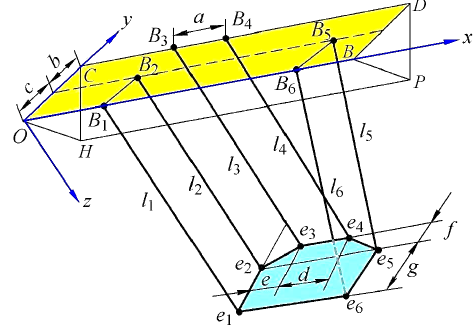
Figure 2. Geometrical model of PCMM.